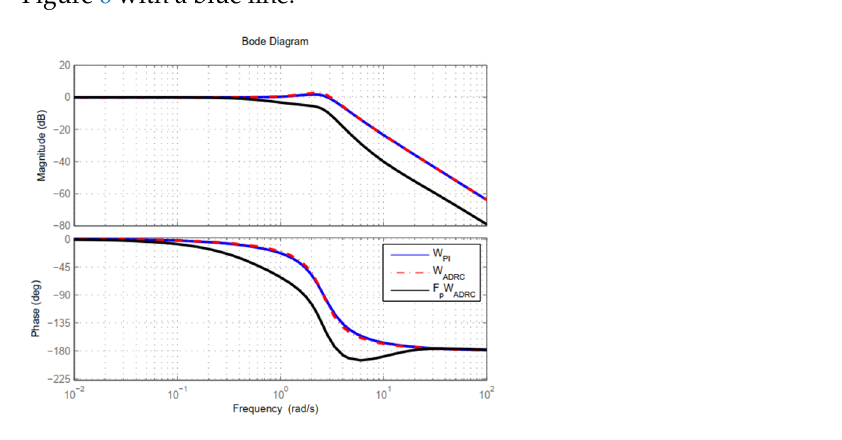
Figure 7. Typical step responses of FOLADRC and PI control. The parameters are: β 2 = 100, b 0 = 2. The plant P ( s ) = 2.25/ ( 1 + 1.5 ) 2